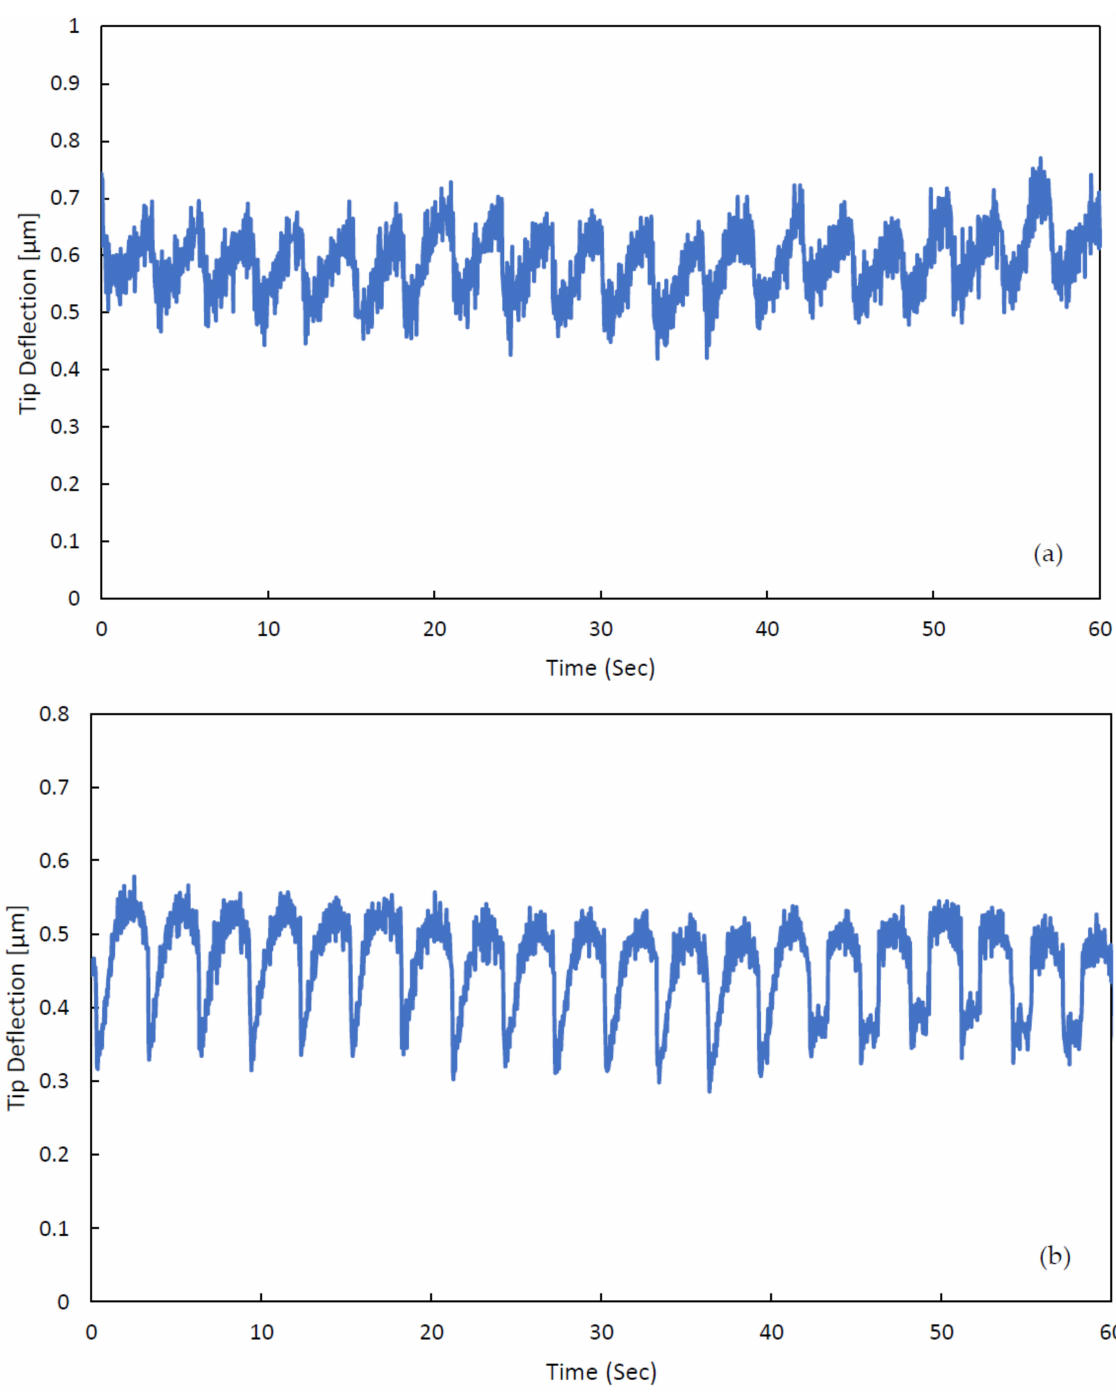
Figure 14. SPMF 3 response to dynamic load of a Peristaltic pump with a fixed speed of 2 rpm, which was generating flow pulses of 0.33 Hz due to 10 rotating rollers of the pump, i.e., 20 pulses in 60 s. ( a ) The SPMF 3 sample has a microchannel of 400 × 100 µ m 2 (width and depth). ( b ) The SPMF 3 sample has a microchannel of 200 × 100 µ m 2